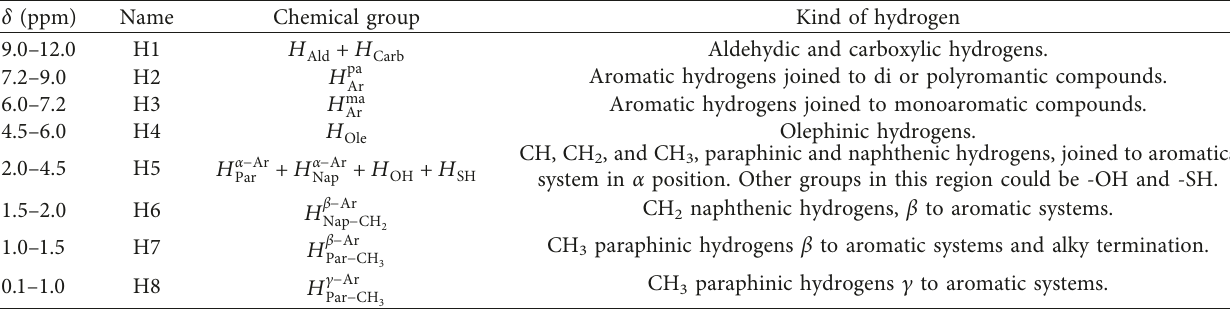
Table 4: Kind of hydrogen and NMR intervals for crude oil characterization.